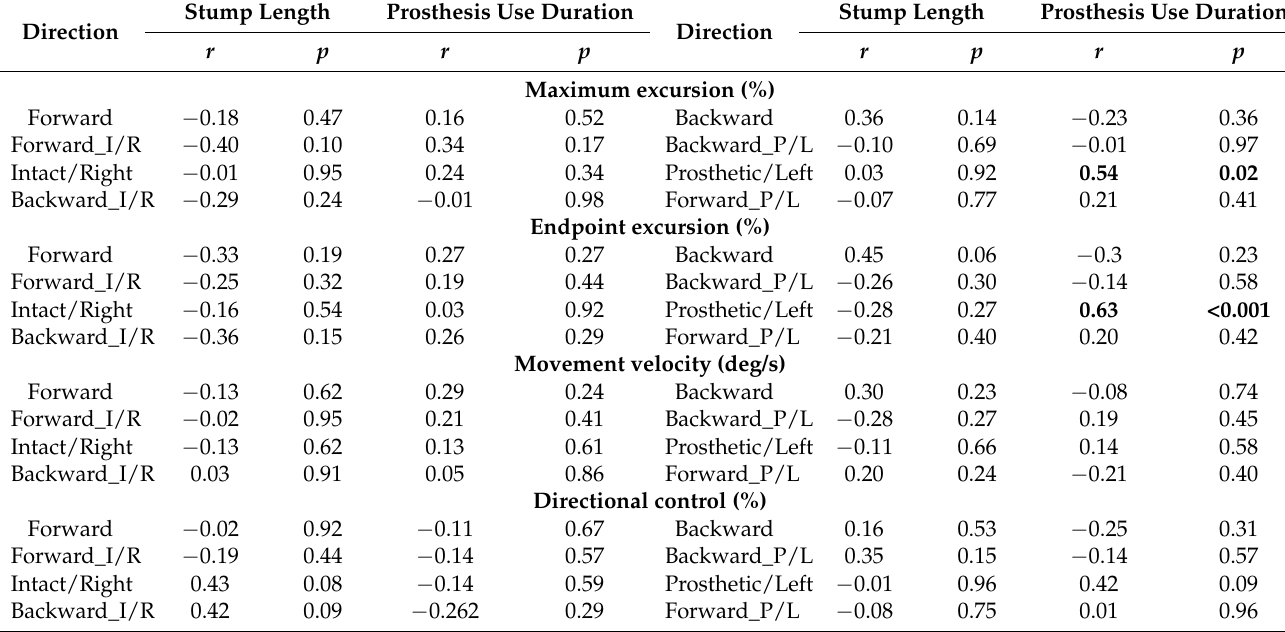
Table 5. Associations between amputation characteristics and outcomes of limits of stability test.